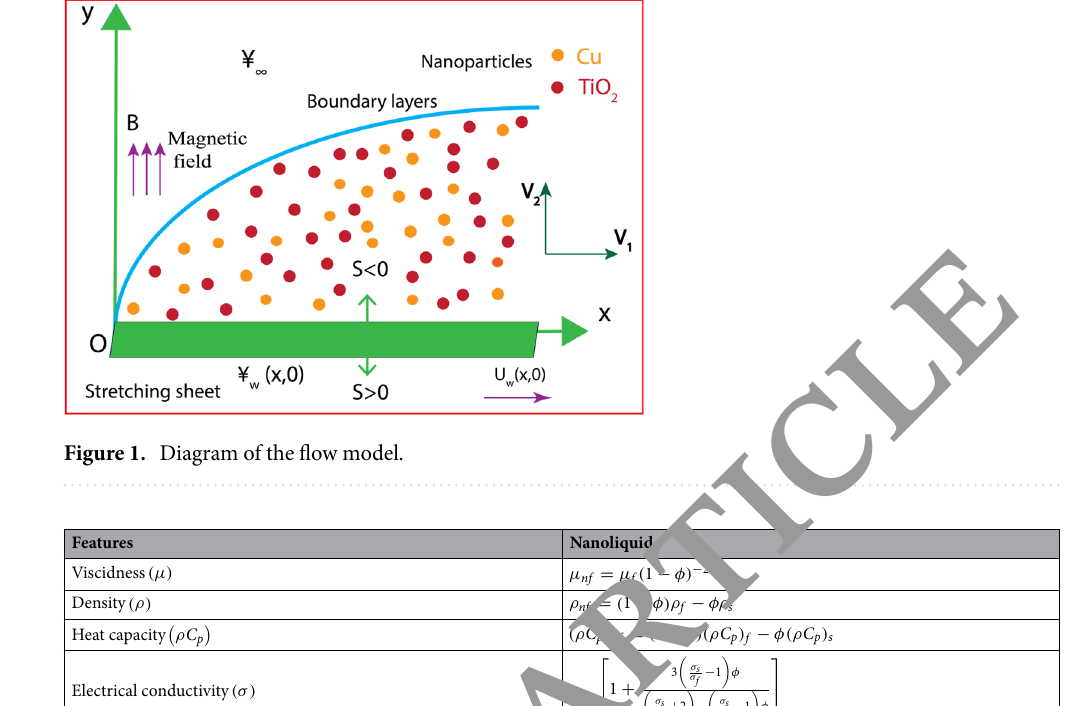
Table 1. Thermo-physical aspects of